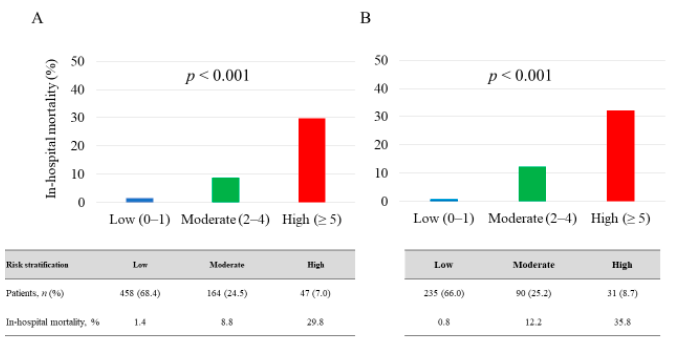
Figure 3. Risk stratification for predicting in-hospital mortality. ( A ) derivation cohort and ( B ) validation cohort. The low-, moderate-, and high-risk groups have scores assigned as follows: 0–1, 2–4, and ≥ 5, respectively.